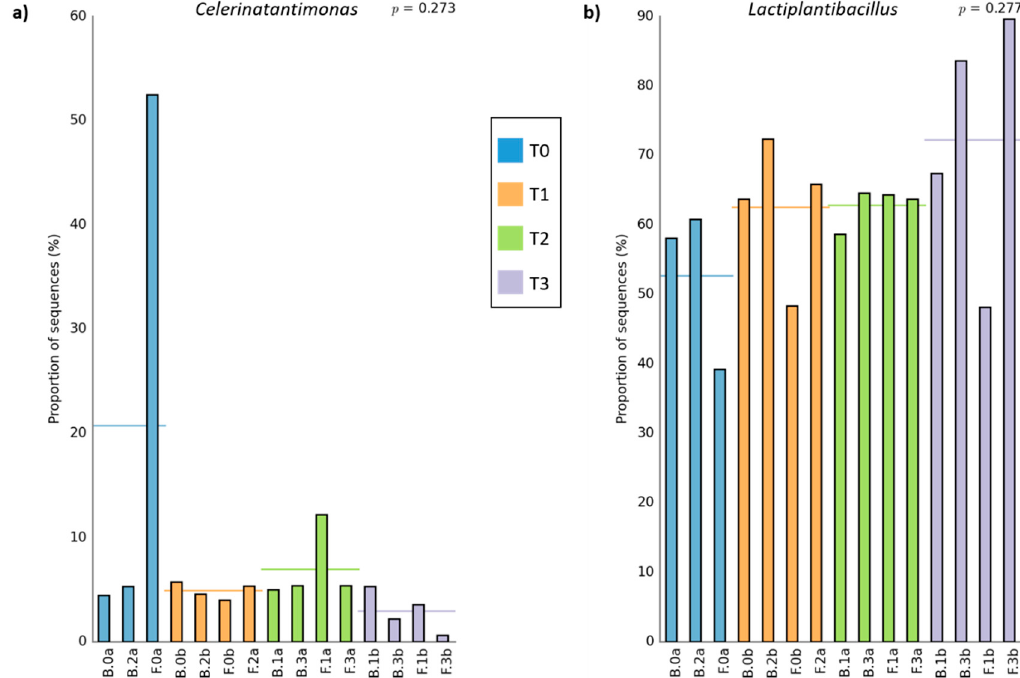
Figure 4. Bar plot showing the relative proportion of Celerinatantimonas ( a ) and Lactiplantibacillus ( b ) genera in the different samples of traditional packed Aloreña de Málaga . Horizontal lines indicate mean values (n = 3 or n = 4) for each sampling time (T0, 0 day; T1, 42 days; T2, 130 days; T3, 260 days). B stands for brines, while F stands for fruits.